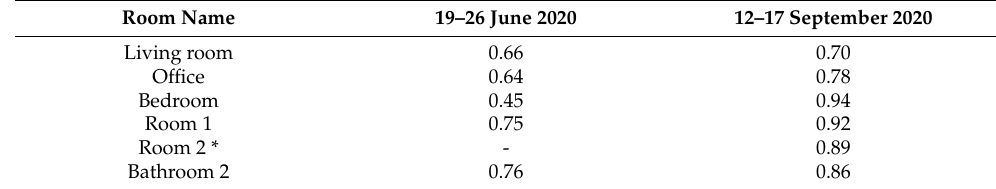
* Measurement was not conducted in room 2 in first period. Table 4. Values of normalized mean bias error (NMBE) and coefficient of variation of root mean squared error (CV (RMSE)) indicators for periods without occupants.